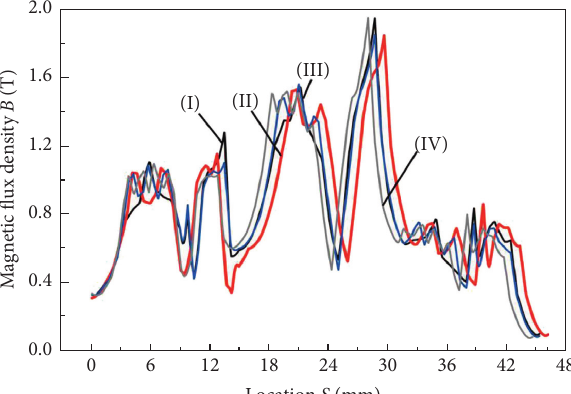
Figure 4: Magnetic field distribution in magnetic fluid sealing clearance with different radial teeth numbers (I), 1; (II), 2; (III), 3; and (IV),